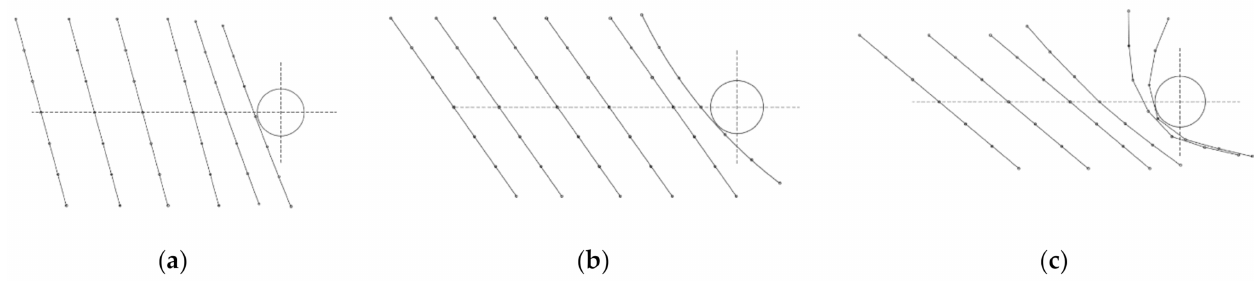
Figure 10. Movement of a single fibre past a cylinder where the ratio of the fibre length to the cylinder diameter is 4: . ∗ = γ ( a ) 1.3 × 10 − 4 , θ = 15 ◦ , ( b )